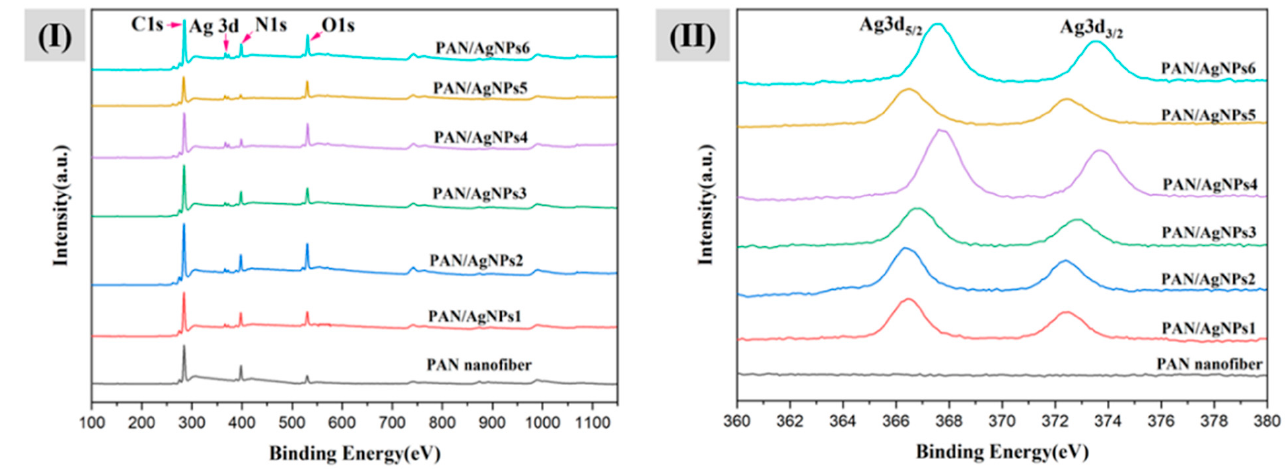
Figure 5. ( I ) X-ray Photoelectron Spectroscopy (XPS) wide spectra of PAN nanofiber, PAN/AgNPs1, PAN/AgNPs2, PAN/AgNPs3, PAN/AgNPs4, PAN/AgNPs5, and PAN/AgNPs6; ( II ) XPS narrow spectra of PAN nanofiber, PAN/AgNPs1, PAN/AgNPs2, PAN/AgNPs3, PAN/AgNPs4, PAN/AgNPs5, and PAN/AgNPs6 over Ag 3d region.